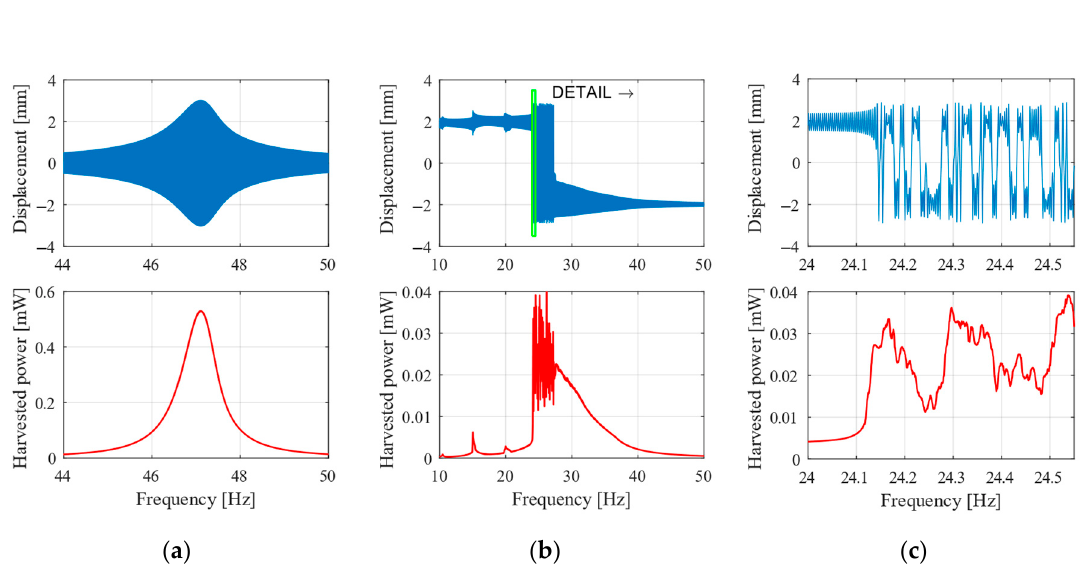
Figure 2. Sweep up with amplitude 0.5 g. ( a ) Linear, ( b ) nonlinear oscillator, and ( c ) detail of nonlinear oscillatations.